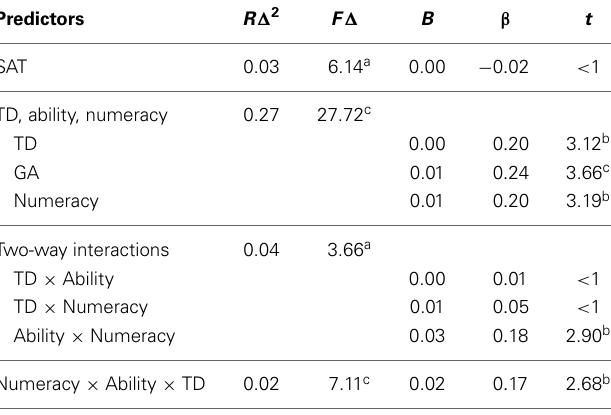
Table 4 | Hierarchical multiple regression analysis on composite scores ( β and t -values from final step).